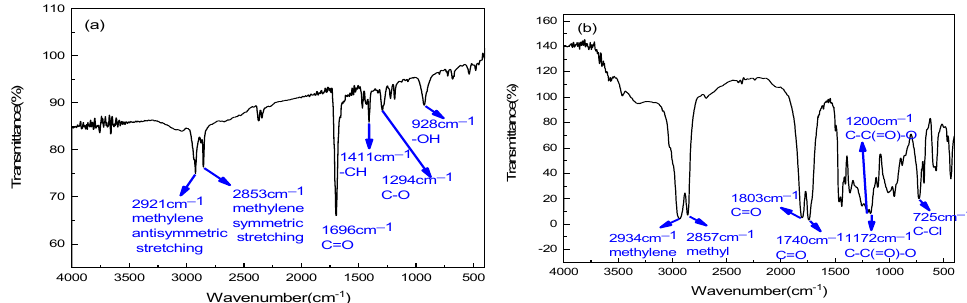
Figure 3. FTIR spectra of ( a ) dodecanedioic acid and ( b ) 12-chloro-12-oxododecanedioic acid-methyl ester.